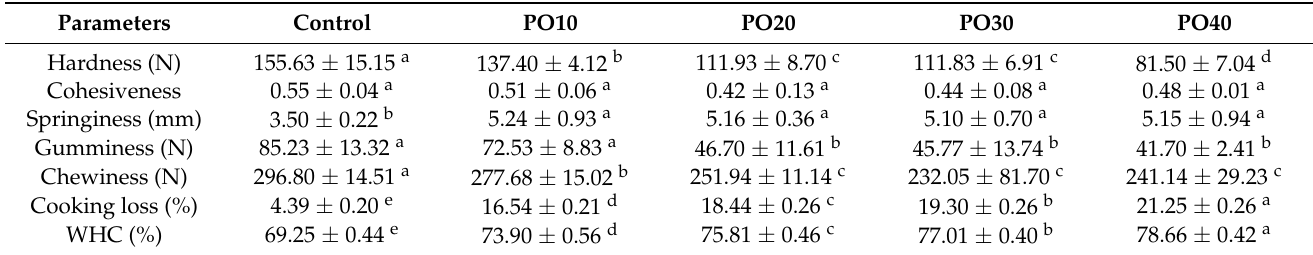
Table 4. Texture parameter analysis (TPA), cooking loss (%), and water holding capacity (WHC) of Pleurotus ostreatus (PO) pork